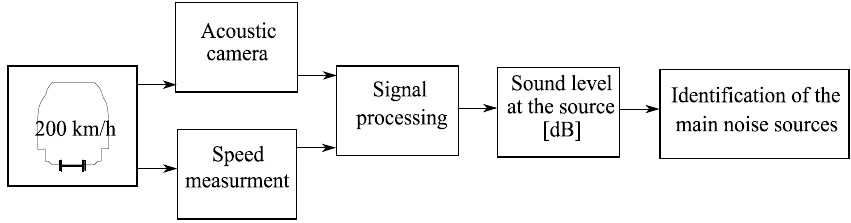
Figure 1. A block diagram of the tests carried with the use of an acoustic camera.